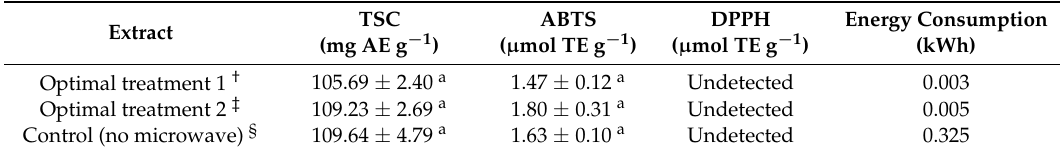
Table 2. Saponin content, antioxidant activities and energy consumption of the optimal MAE and control